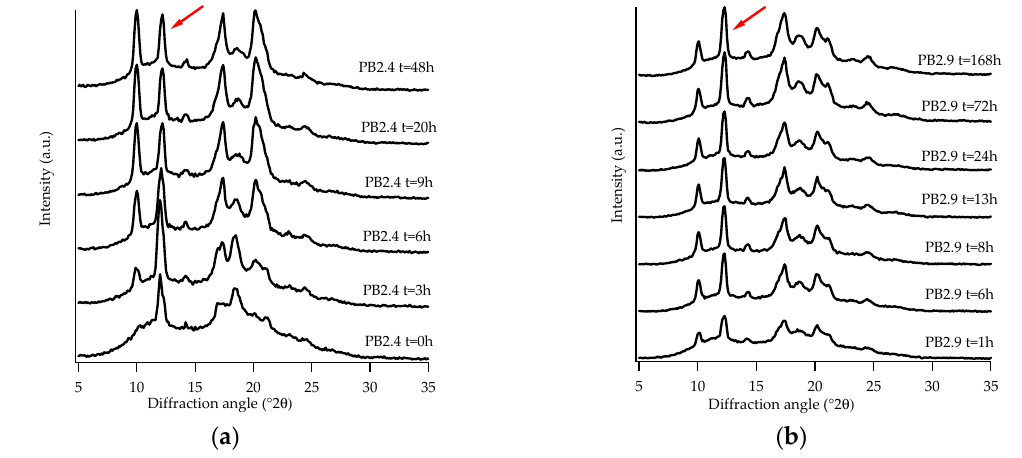
Figure 7. WAXD patterns of sample PB2.4 ( a ) and PB2.9 ( b ) subjected to pressure. (Red arrows indicate the (101)III peak after completion of phase transformation).